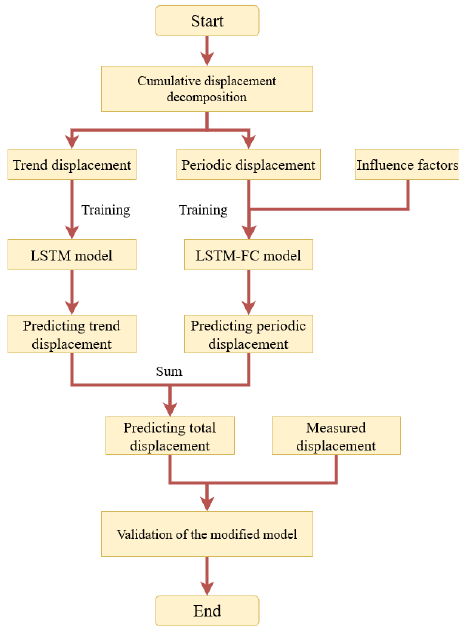
Figure 3. Flowchart of the prediction process .